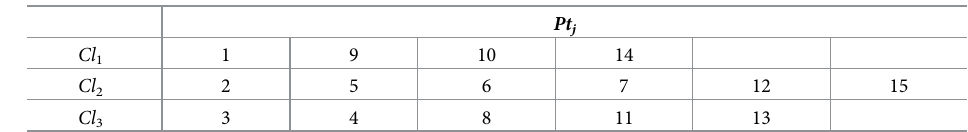
Table 2. Confidentiality levels distribution.